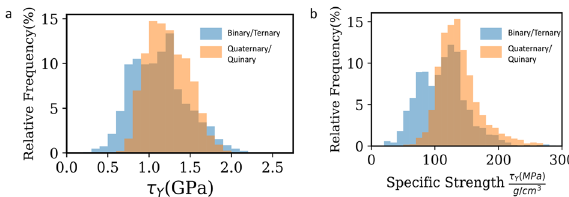
Fig. 7 Distribution of yield strength in the bcc refractory alloys screened to be stable as a single-phase solid solution at 800 °C. Relative frequency histograms of ( a ) room-temperature yield strength and ( b ) room-temperature speci fi c yield